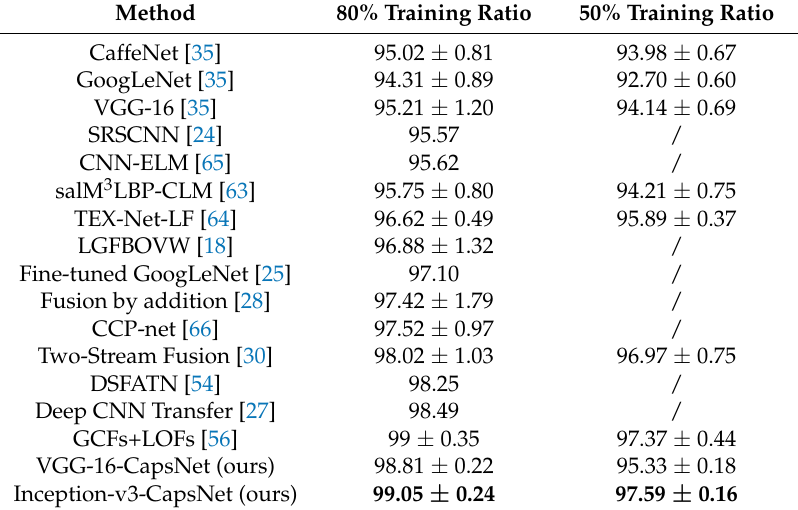
Table 1. Overall accuracy (%) and standard deviations of the proposed method and the comparison methods under the training ratios of 80% and 50% on the UC-Merced